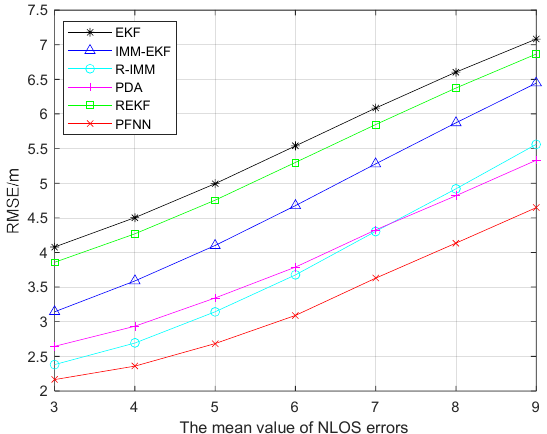
Figure 2. The RMSE versus the mean value of the NLOS error.